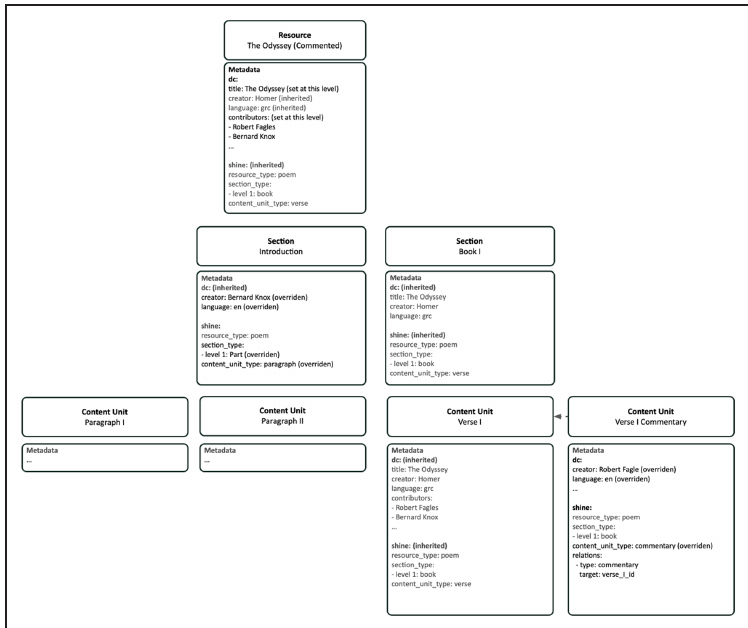
Figure 4: Representing various sections, content units, and their metadata using